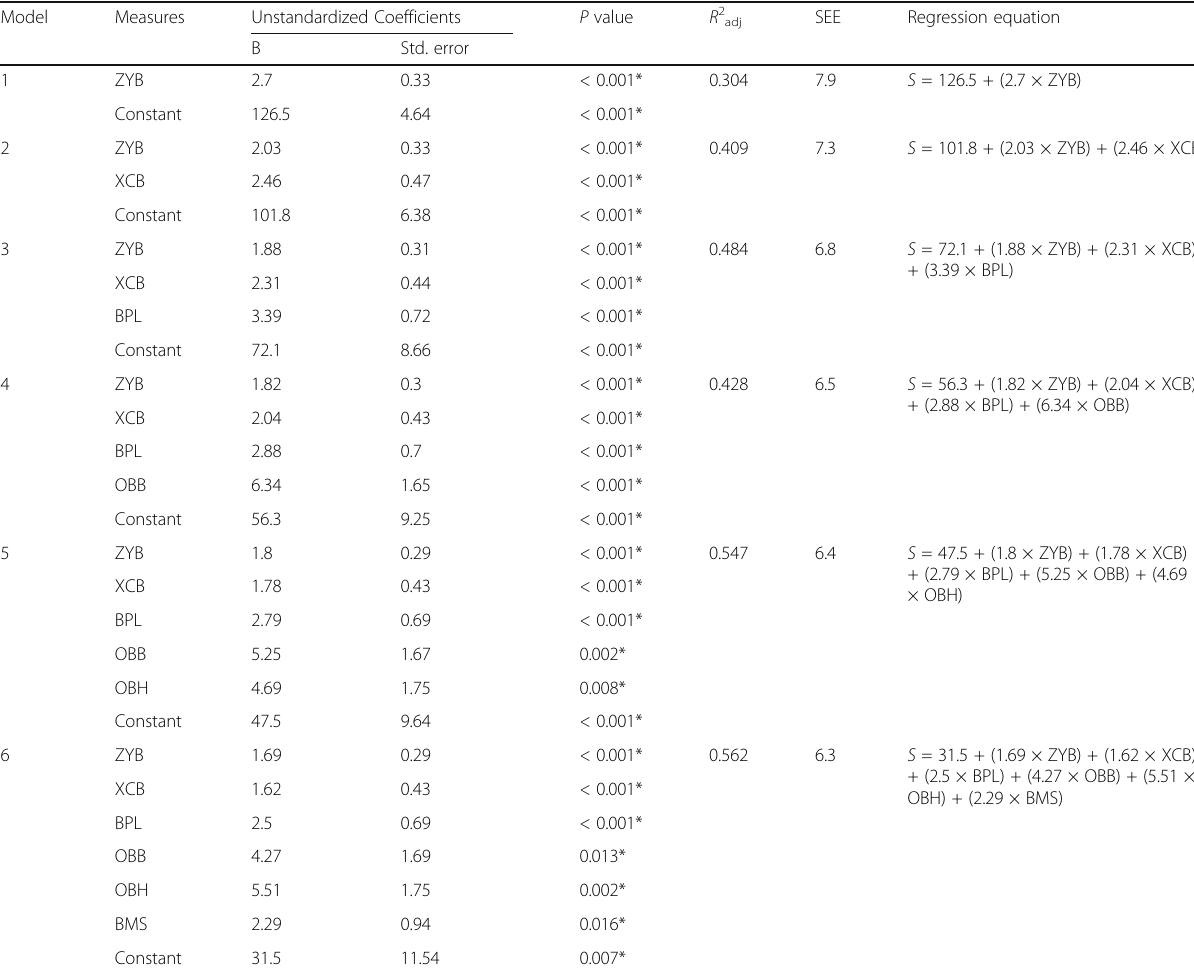
Table 9 Multiple stepwise linear regression analysis of skull measurements for stature estimation in pooled cases ( n = 150)